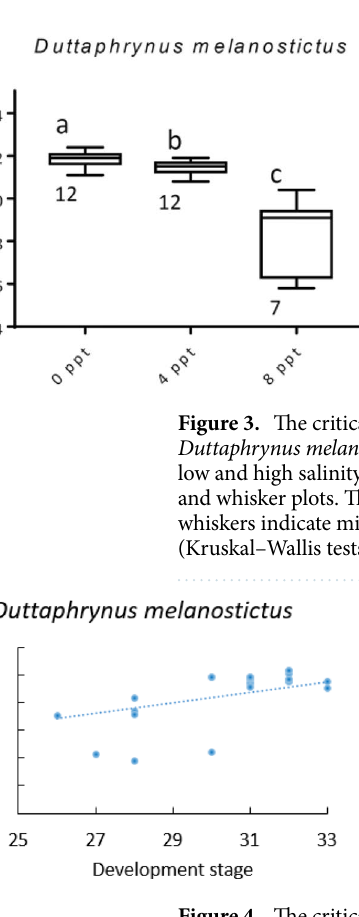
Figure 4. The critical thermal maximum (CTmax) of tadpoles under different development stage. The critical thermal maximum (CTmax) of tadpoles of Duttaphrynus melanostictus (Spearman’s r = 0.34, n = 31, p = 0.061; left), Fejervarya limnocharis (Spearman’s r = 0.75, n = 32, p < 0.001; middle), and Microhyla fissipes (Spearman’s r = 0.33, n = 27, p = 0.096; right) in different development